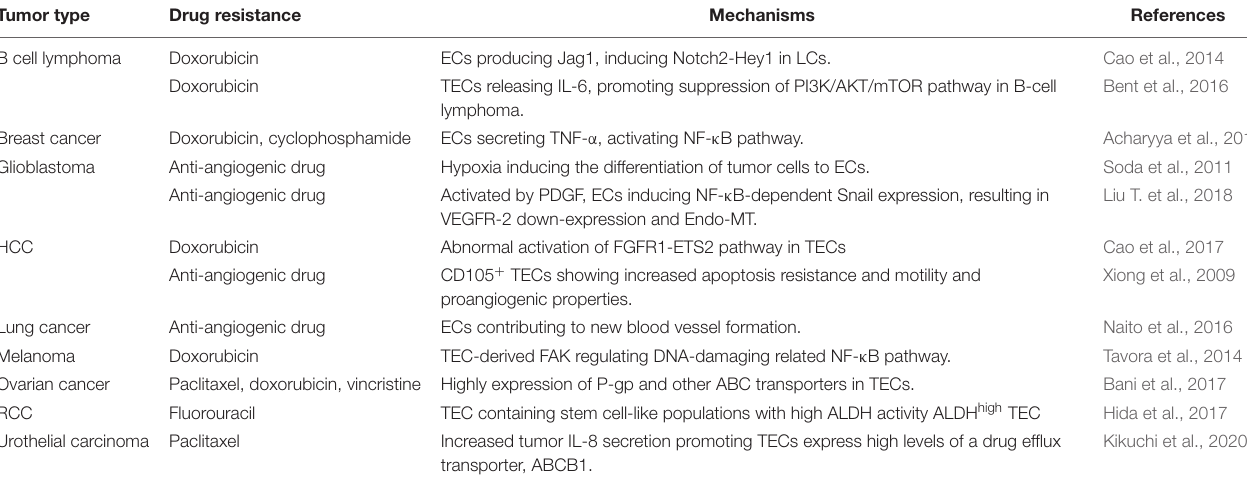
TABLE 7 | Mechanisms of antitumor drug resistance mediated by ECs.